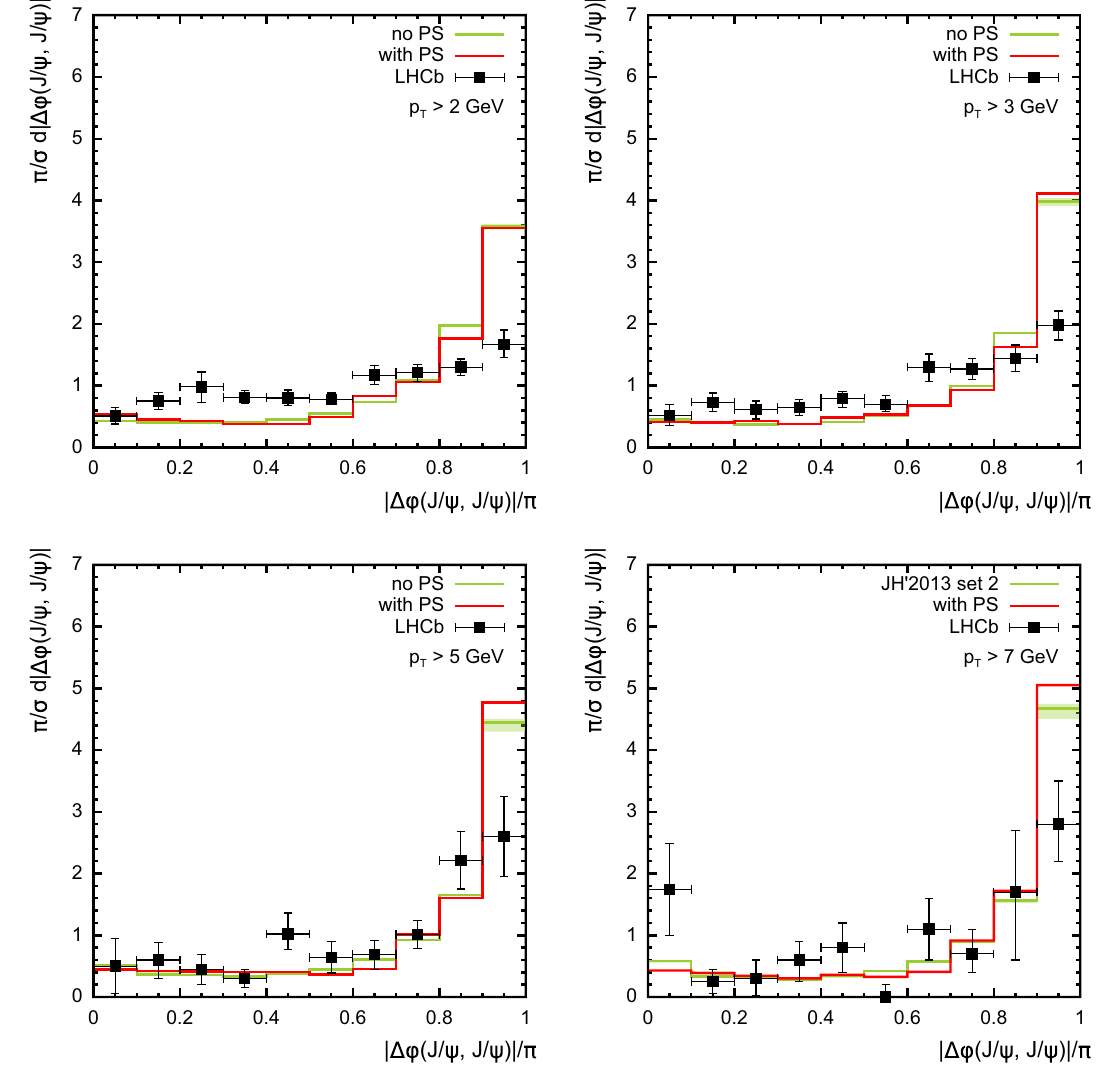
√ s = 8 TeV. The JH’2013